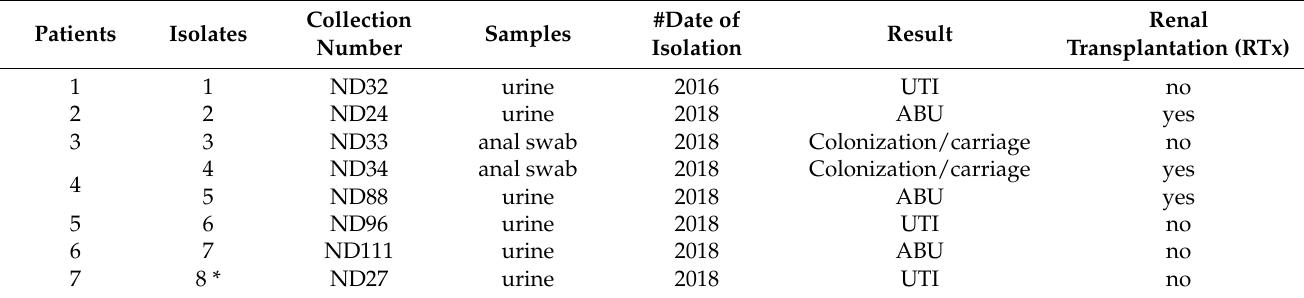
Table 1. Overview of patient and strain details used in the epidemiological